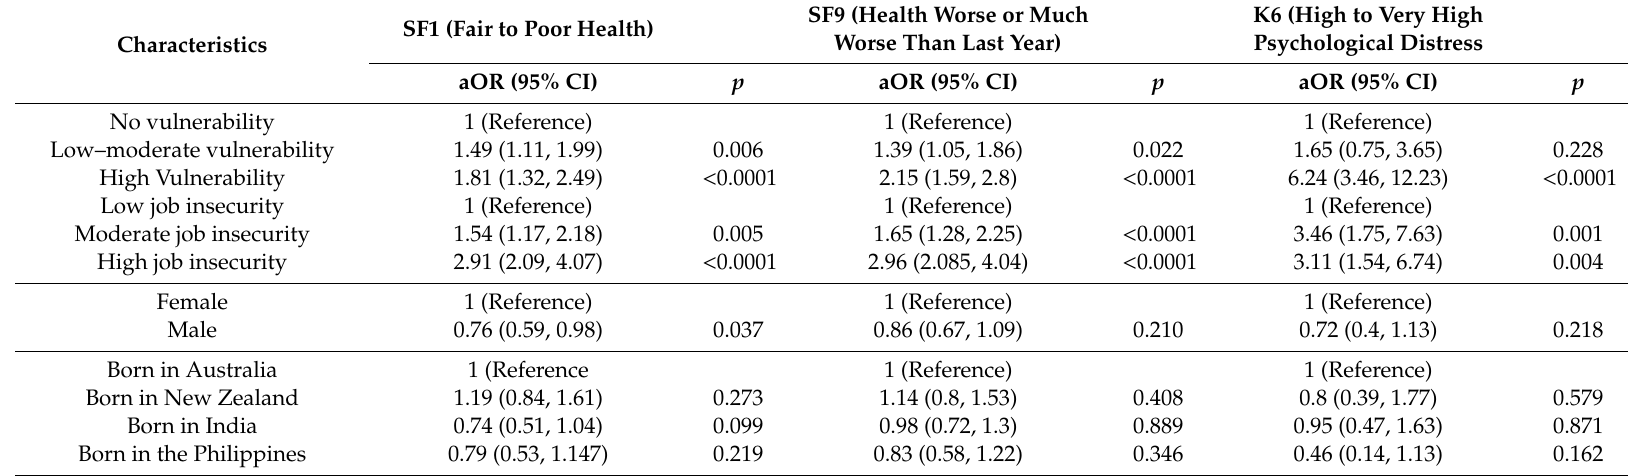
Table 3. Adjusted Odds Ratios and 95% Confidence Intervals for health outcomes for levels of vulnerability, job insecurity, gender and country of birth.